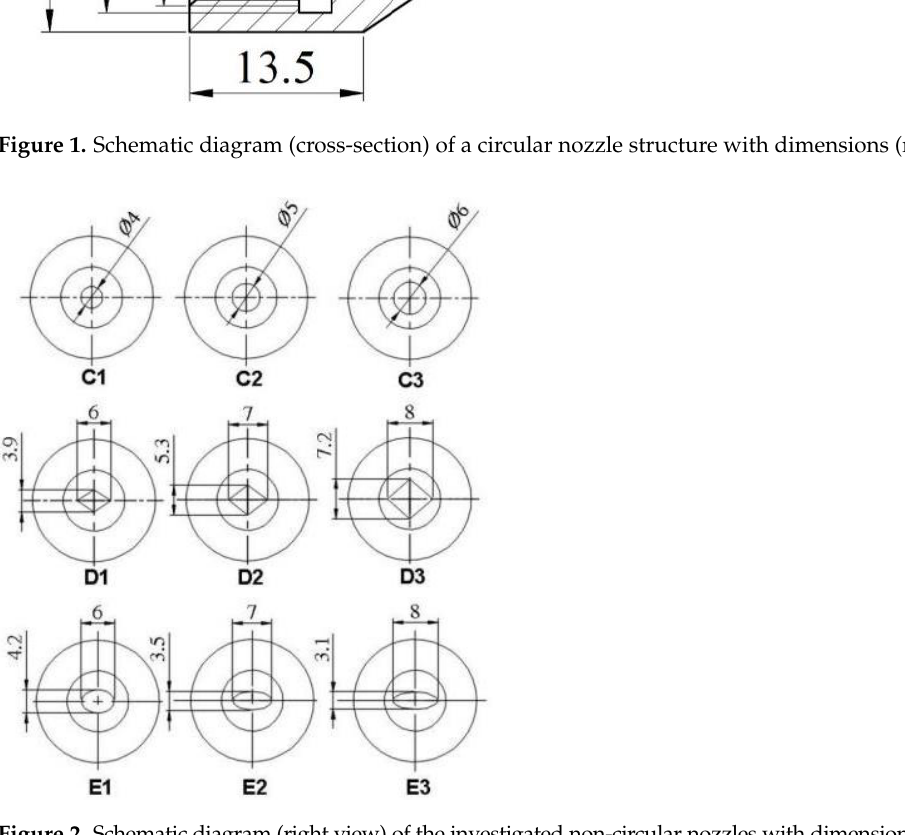
Figure 2. Schematic diagram (right view) of the investigated non-circular nozzles with dimensions (mm). Table 1. Geometric parameters of the circular and non-circular nozzles (mm).